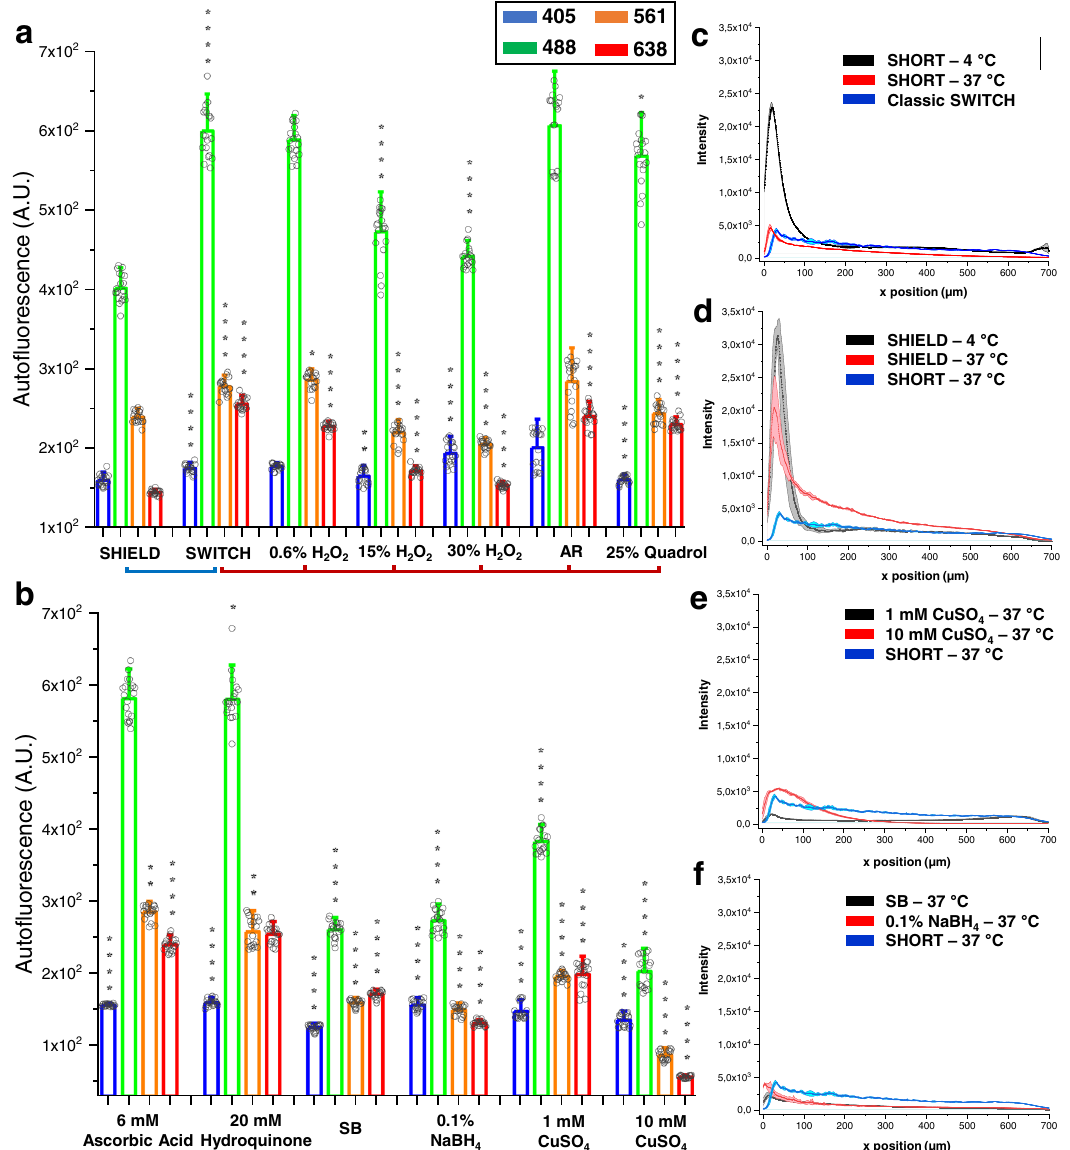
Fig. 1 Effect of auto fl uorescence elimination reagents — AR and NeuN antibody penetration in processed human slices. a , b Comparison of seven different auto fl uorescence elimination reagents and AR in 500 μ m-SWITCH processed slices using LSFM with the excitation light at 405, 488, 561, and 638 nm. For H 2 O 2 and CuSO 4 , we examined three and two different concentrations, respectively. Statistical analysis ( n = 20) was performed between two transformation protocol methods (SWITCH vs SHIELD) ( a ) and classic SWITCH-processed tissue vs auto fl uorescence elimination treatments on SWITCH-treated slices ( a , b ). A Mann – Whitney test was performed (* P < 0.05, ** P < 0.01, *** P < 0.001, **** P < 0.0001). Error bars show mean ± SD. Abbreviation: AR antigen retrieval, SB Sudan black. c , d Effect of temperature (4 °C, 37 °C) and tissue processing (SWITCH, SHIELD, and SHORT), e , f auto fl uorescence treatments (SB, NaBH 4 , and CuSO 4 ) on NeuN immuno fl uorescence labeling. The plot pro fi les in c – f show the mean intensity ± SD of three different regions.